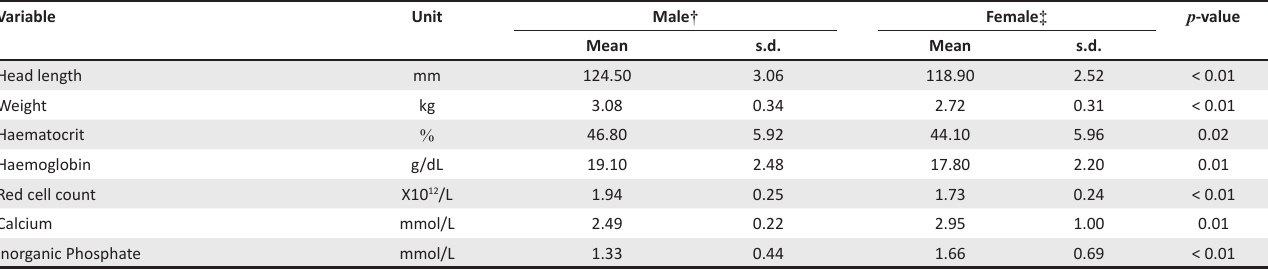
TABLE 2: Mean and standard deviations for haematology and blood chemistry values that were significantly different between sexes of African penguins, using an independent sample t -test. Variable